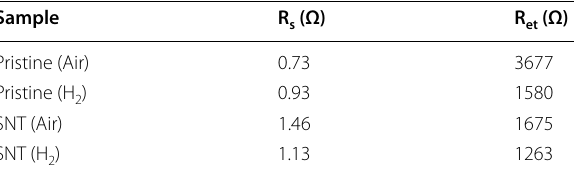
Table 1 Resistance calculation results from the equivalent circuit Sample R s (Ω) R et (Ω) Pristine (Air)